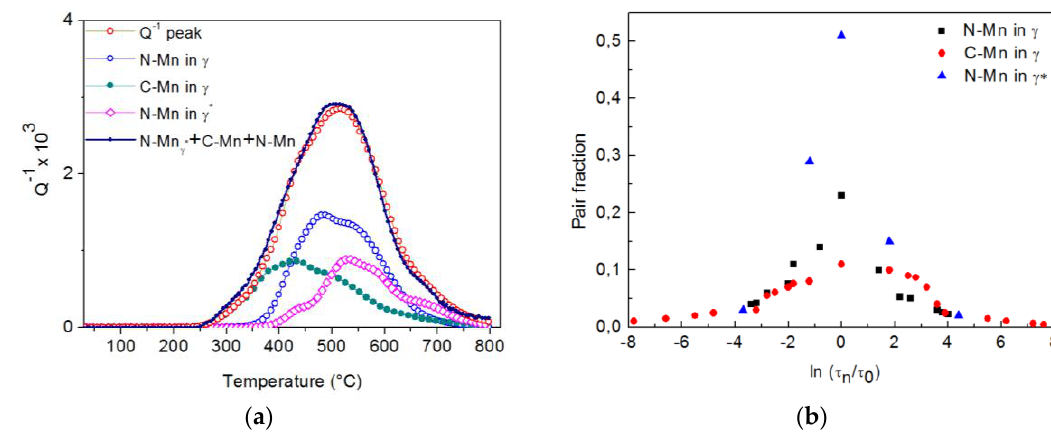
Figure 10. ( a ) Fitting of the Q −1 peak of the heat treated steel. ( b ) Distributions of relaxation times τ n used to get the best fit displayed in ( a ).